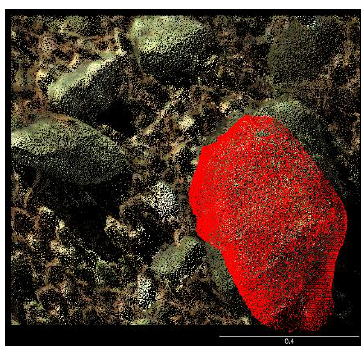
Figure 10 Position of point clouds after initial transformation, red – aligned point cloud